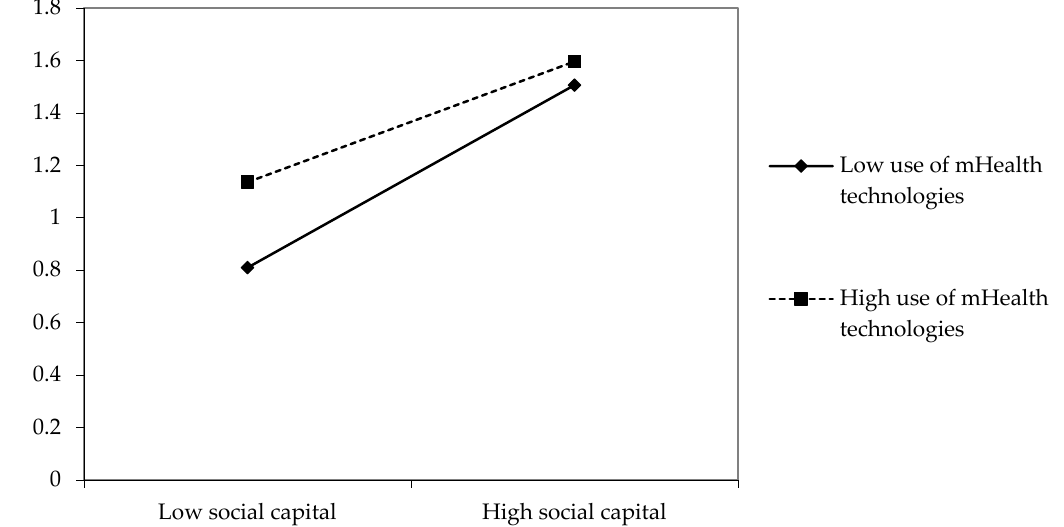
Figure 3. Interaction effects between social capital and use of mHealth technologies on health self- efficacy.